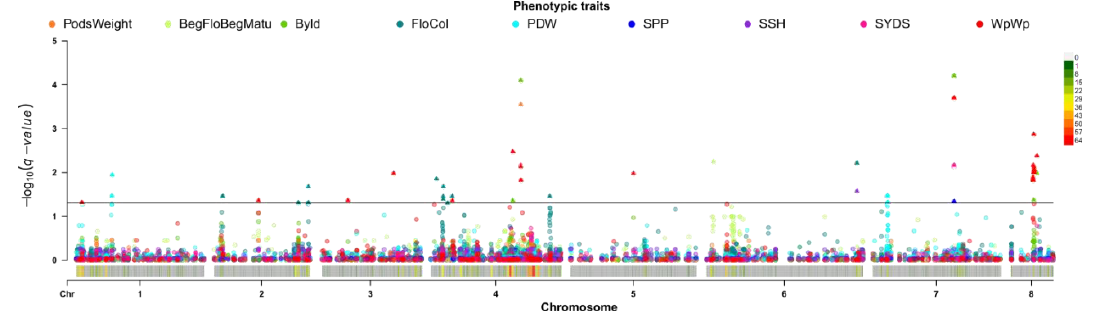
Figure 6. Summary of GWAS analyses with eight PCs as covariates for phenotype data (different colors correspond to different phenotype). SNPs with q-value < 0.05 are shown for each chromosome, marked as triangles. Chromosome density is attached on the bottom of the Manhattan plot.